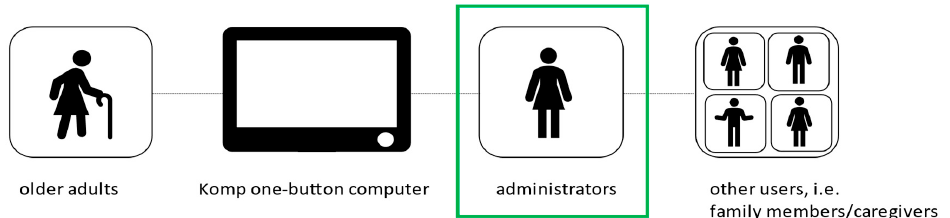
Figure 2. The social network facilitated by Komp. (Ill: Antje Gonera, Nofima). One person functions as administrator of the app. All app users, such as family mem- bers or caregivers, must be invited in order to access the Komp Family app, which func- tions as a private social network. Through the app, one can send photos and messages